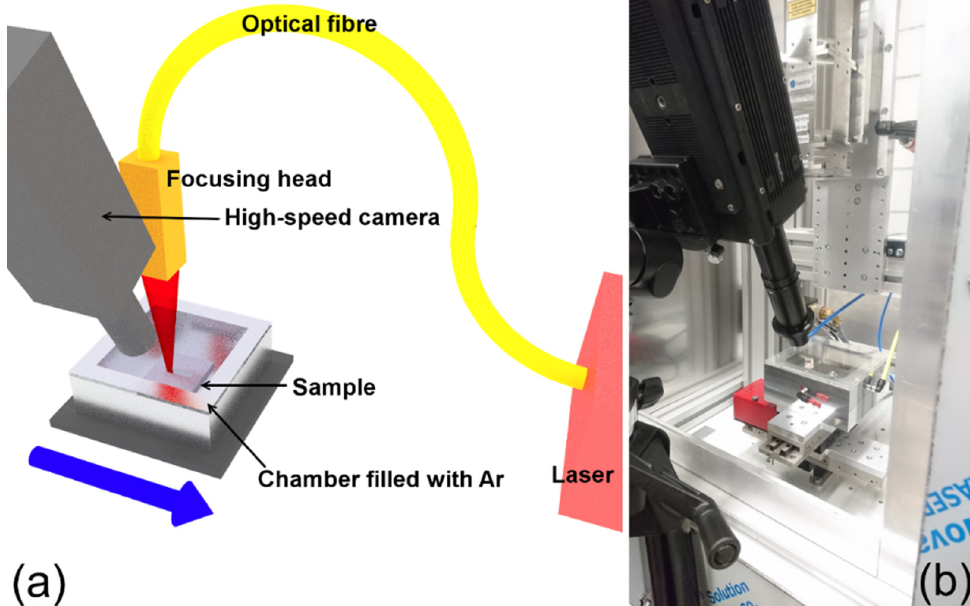
Figure 3. ( a ) Schematic representation of the experimental setup of LP. ( b ) photography of the actual setup. Taken from Meylan et al. [22]; published by MPDI under CC BY 4.0.